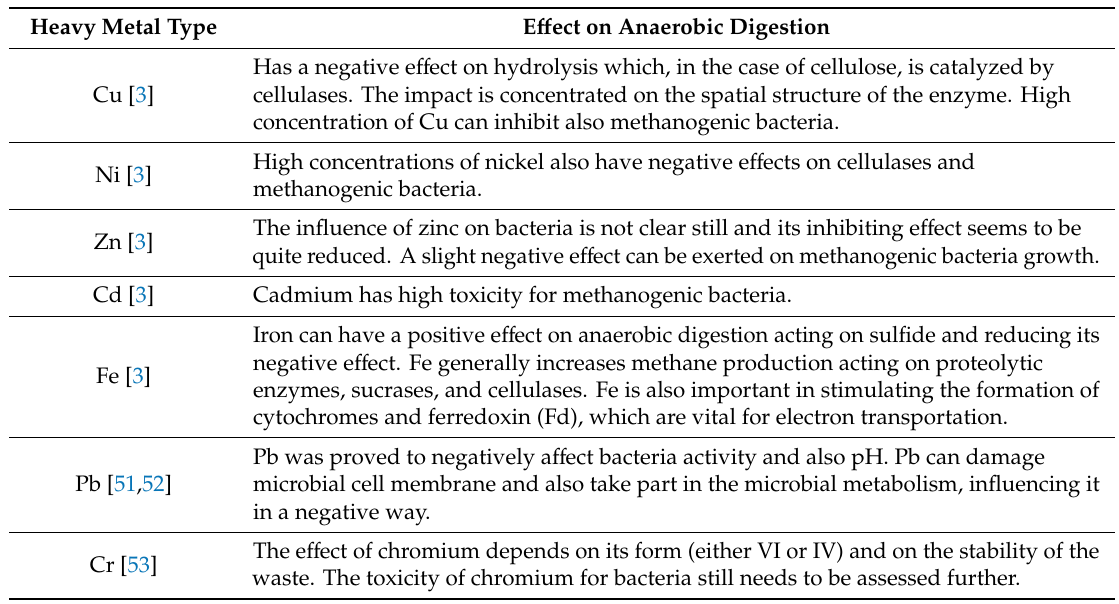
Table 6. E ff ects of heavy metals on the anaerobic digestion process